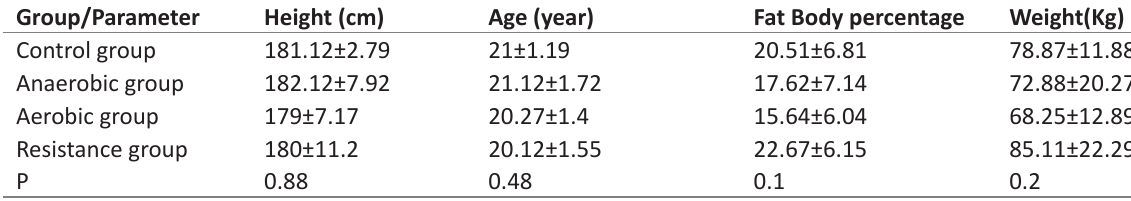
Table 5. Statistics related to the happiness mediators ExercisesParameter